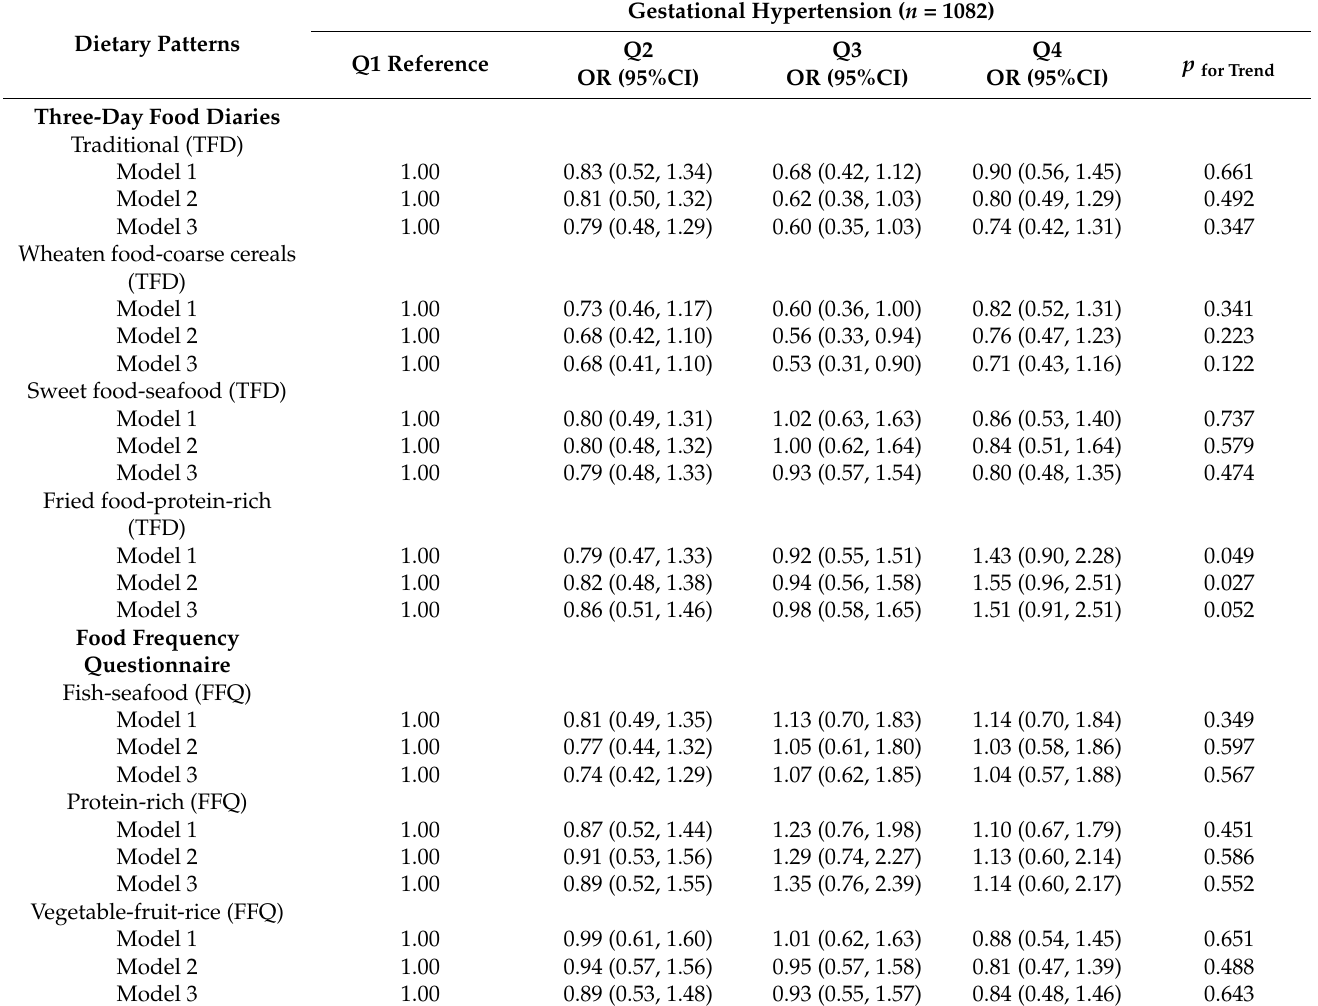
Model 1: Crude model; Model 2: Adjusted for other dietary pattern scores from the same dietary assessment tool (TFD or FFQ); Model 3: Model 2 + age, parity, family income, education level, ethnicity, smoking status, total energy intake per day, physical activity status per week, pre-pregnancy BMI, and history of diabetes; Q1: quartile, Q2: quartile 2, Q3: quartile 3, Q4: quartile 4, CI: confidence interval, TFD: three-day food dairies, FFQ: food frequency questionnaire, BMI: body mass